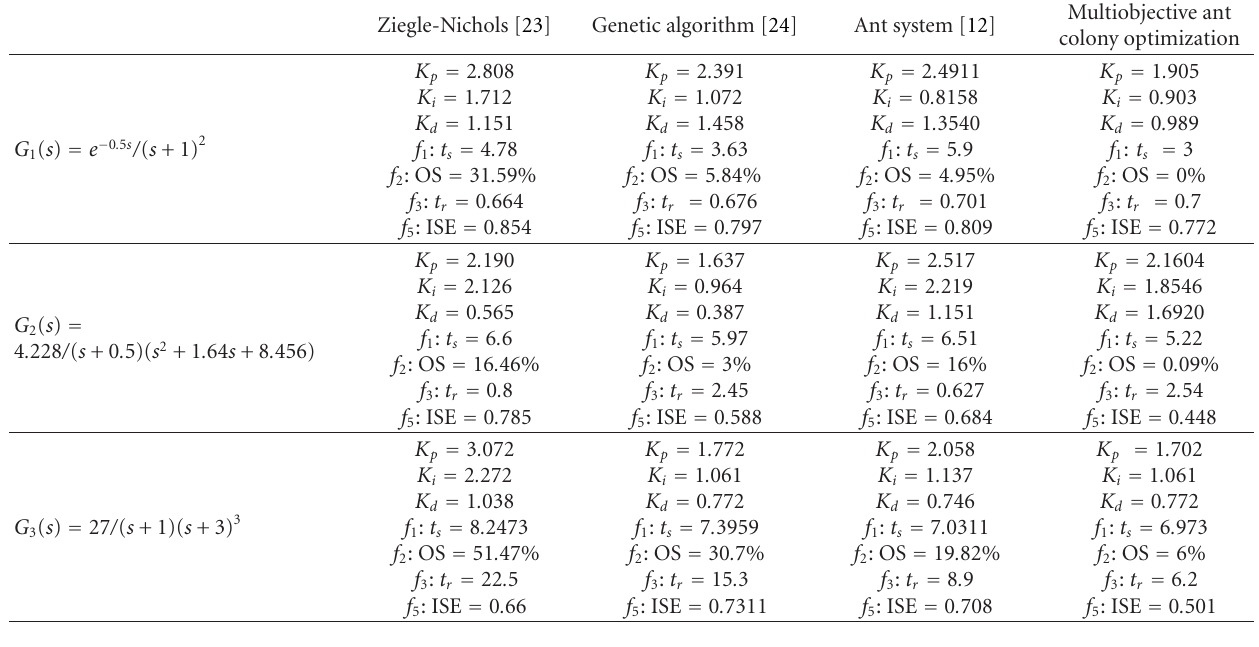
Table 1: Simulation results.